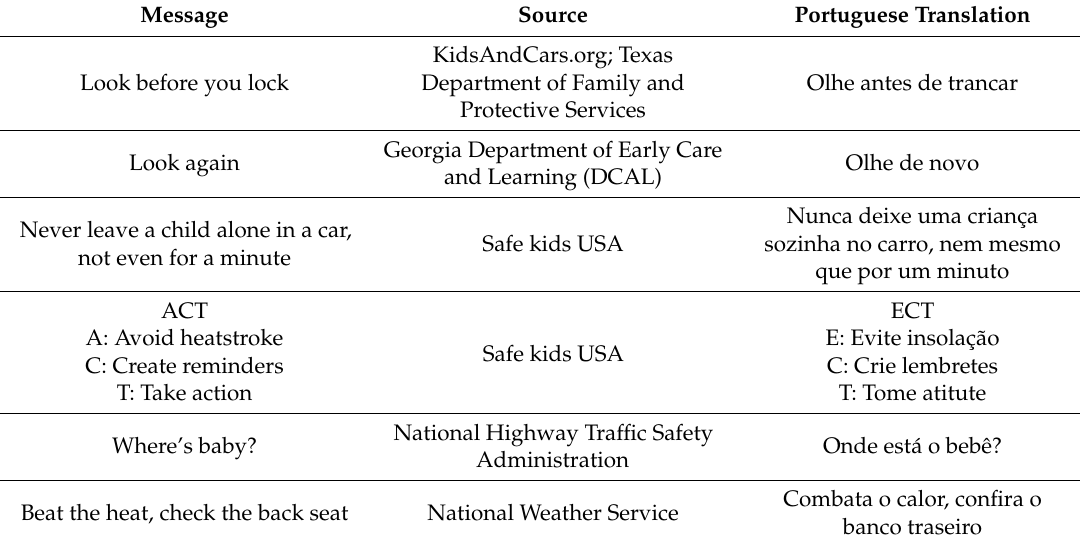
Table 3. Public safety messages related to children unattended in hot vehicles.